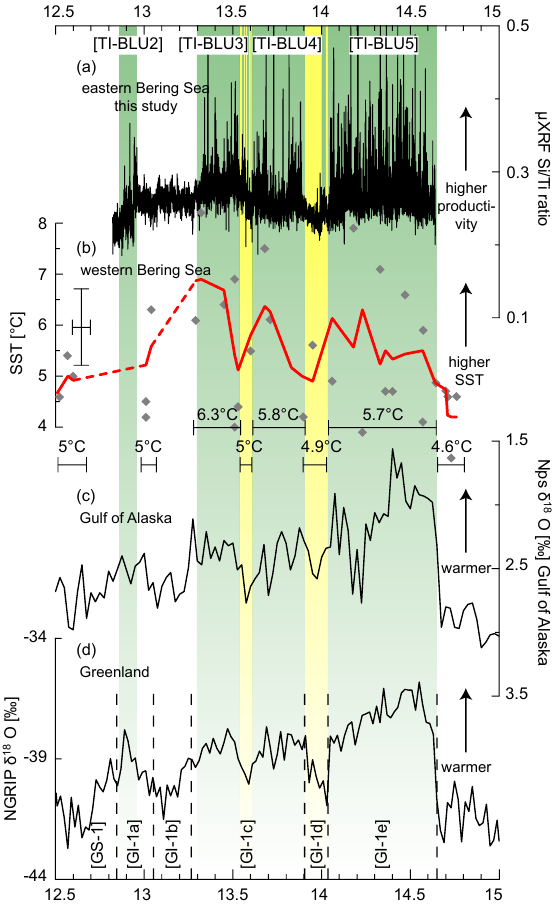
Figure 10. Comparison of laminated core SO202-18-3 with Bering Sea SST records, planktic δ 18 O data from the Gulf of Alaska, and Greenland temperature changes across the Bølling–Allerød time in- terval. (a) Micro-XRF Si/Ti ratios of SO202-18-3. (b) In red the stacked SST record (three-point running mean) of cores SO201- 2-77, SO201-2-2-85, and SO201-2-101 from the Shirshov Ridge, western Bering Sea. The gray squares depict the individual SST measurements (Max et al., 2012). Dashed parts in the SST record indicate intervals with insufficient temperature data. The age model used in this plot is the published model of Max et al. (2012). The nu- merical temperatures below graph (b) are the calculated mean SSTs from the marked warm and cold intervals, and the horizontal bars indicate the temporal range of the average SST. The error bars on the left side of (b) show the uncertainties of SST measurements and radiocarbon datings. (c) δ 18 O data of planktic foraminifera Neogloboquadrina pachyderma sinistral from the Gulf of Alaska as a proxy of long-term changes in annual average SST (Praetorius and Mix, 2014). Note that we used the age model after Praetorius and Mix (2014). (d) NGRIP stable isotope data as reference record. The occurrence of mainly Laminated Facies, Layered Facies, and Bioturbated Facies in SO202-18-3 is shown in green, yellow, and white, respectively. Laminated sections in SO202-18-3 are labeled TI-BLU as in the